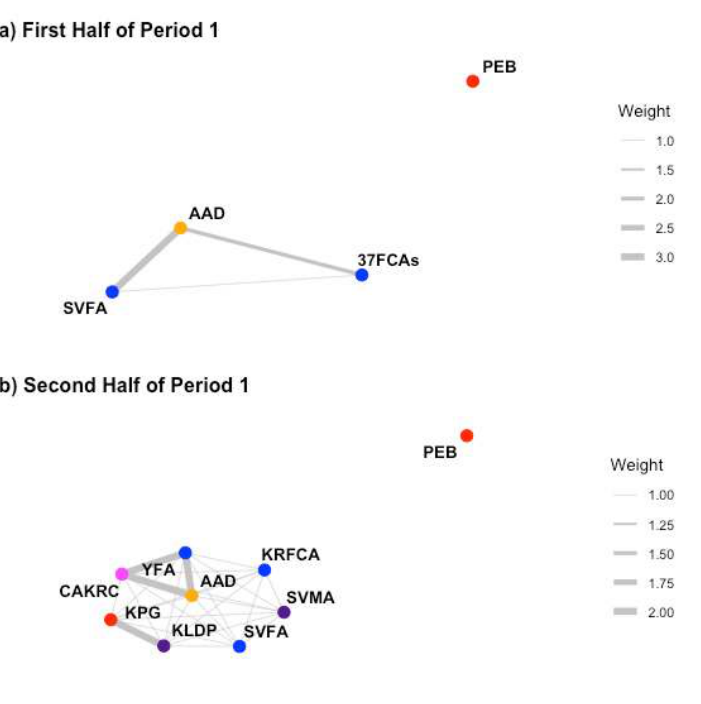
Figure 1. Changes in actors’ congruence networks (Period 1)